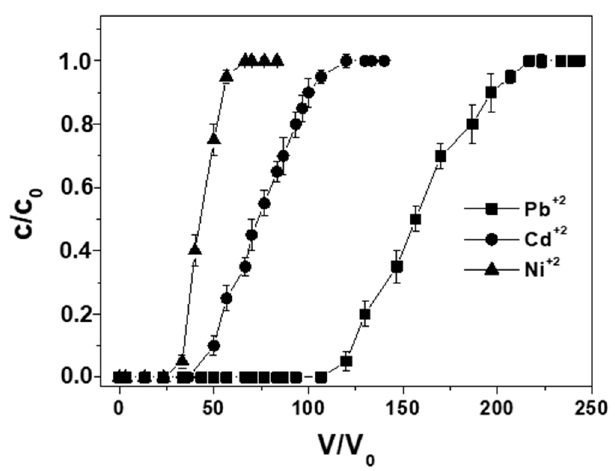
Figure 5. Breakthrough curves in distilled water for multimetal solutions of lead, cadmium, and nickel Table 4. Sorption parameters for multimetal solutions of lead, cadmium and nickel ions at different metal concentration (0.2 Lh − 1 flow rate, 10 g RWPG, 0.5–1 mm bead size range, and T = 298 K). Test